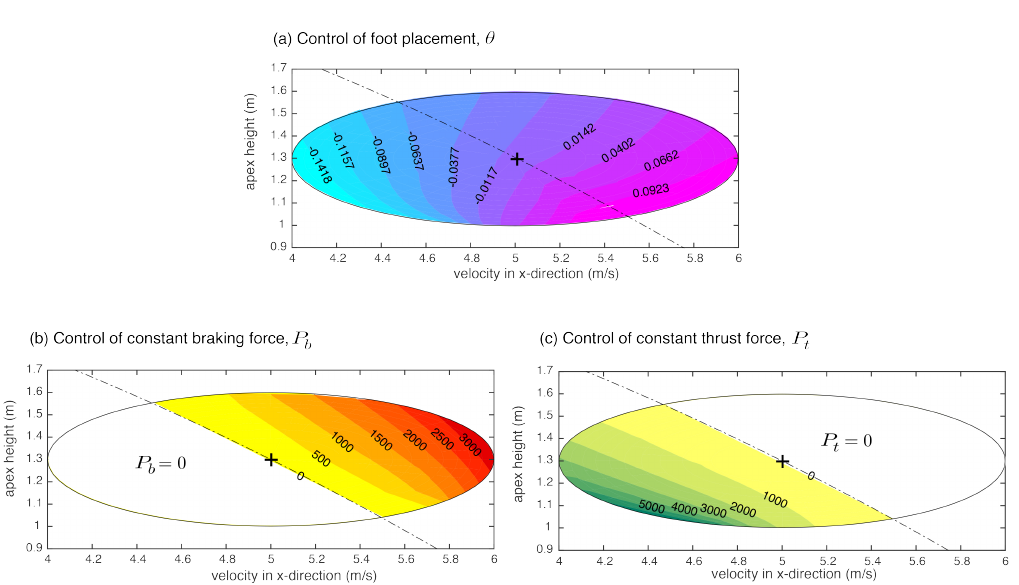
Figure 3. Contour plots for control actions as a function of horizontal velocity and apex height. ( a ) Foot placement angle; ( b ) constant braking force in stance phase; and ( c ) constant thrust force in the restitution phase.